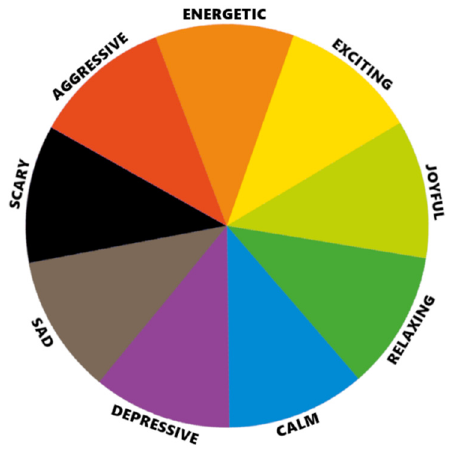
Figure 3. Proposed emotion model.